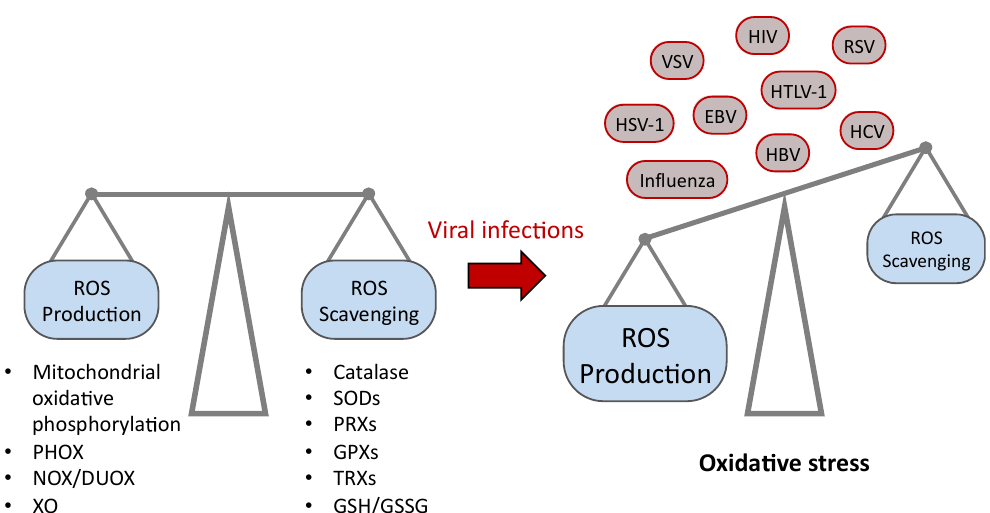
Figure 1. Balance between the generation of reactive oxygen species (ROS) and their scavenging systems in human. This equilibrium can be unbalanced during viral infections, resulting in oxidative stress. The main ROS producing systems include the mitochondrial oxidative phosphorylation, the phagocytic cell NAPDH oxidases (PHOX), the NADPH oxidases / dual oxidases (NOX / DUOX) and the xanthine oxidase (XO). The main ROS scavenging systems include the catalase, the superoxide dismutases (SODs), the peroxiredoxins (PRXs), the glutathione peroxidases (GPXs), the thioredoxins (TRXs) and the balance between reduced and oxidized glutathione (GSH / GSSG). The viruses for which an oxidative stress has been reported are herpes simplex virus type 1 (HSV-1), influenza viruses, vesicular stomatitis virus (VSV), Epstein-Barr virus (EBV), human immunodeficiency virus (HIV), human T cell leukaemia virus type 1 (HTLV-1), hepatitis B virus (HBV), respiratory syncytial virus (RSV) and hepatitis C virus (HCV) [34].